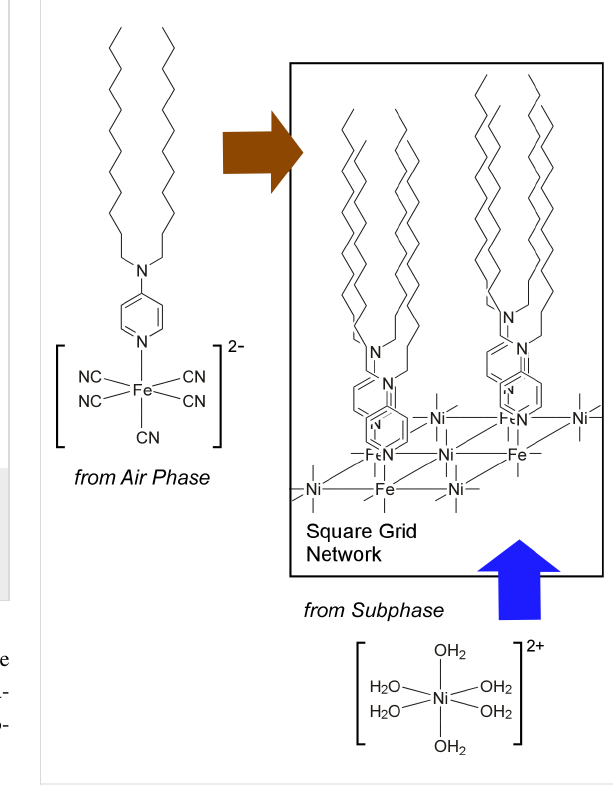
Figure 9: Formation of a two-dimensional iron–nickel cyanide-bridged network at the air–water interface through reaction of a Langmuir monolayer of an amphiphilic pentacyanoferrate complex with Ni 2+ ions from the